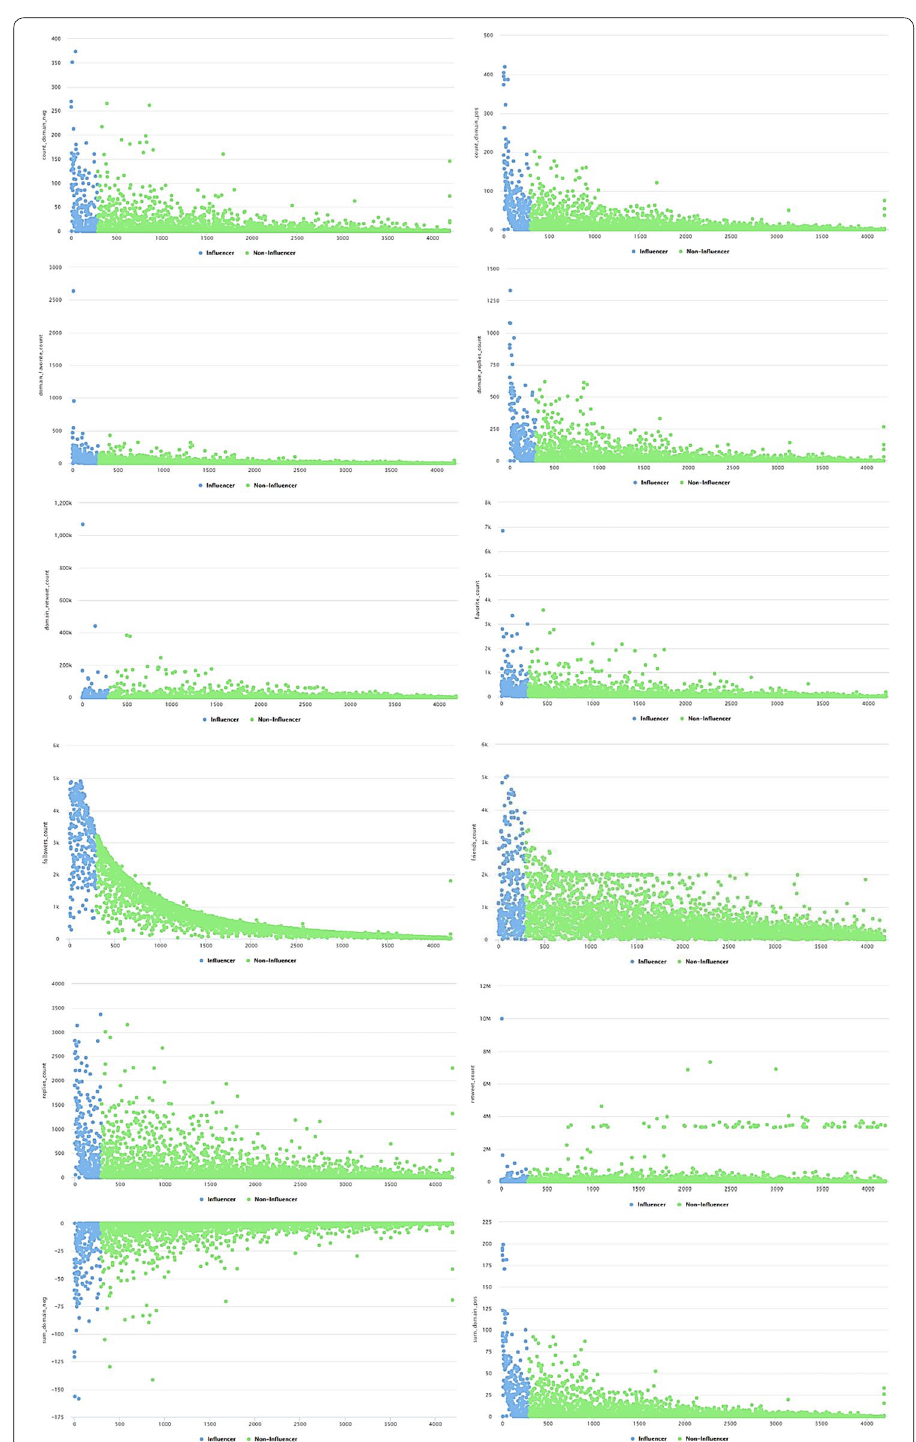
Fig. 4 Correlation between the trustworthiness values for each feature in IT